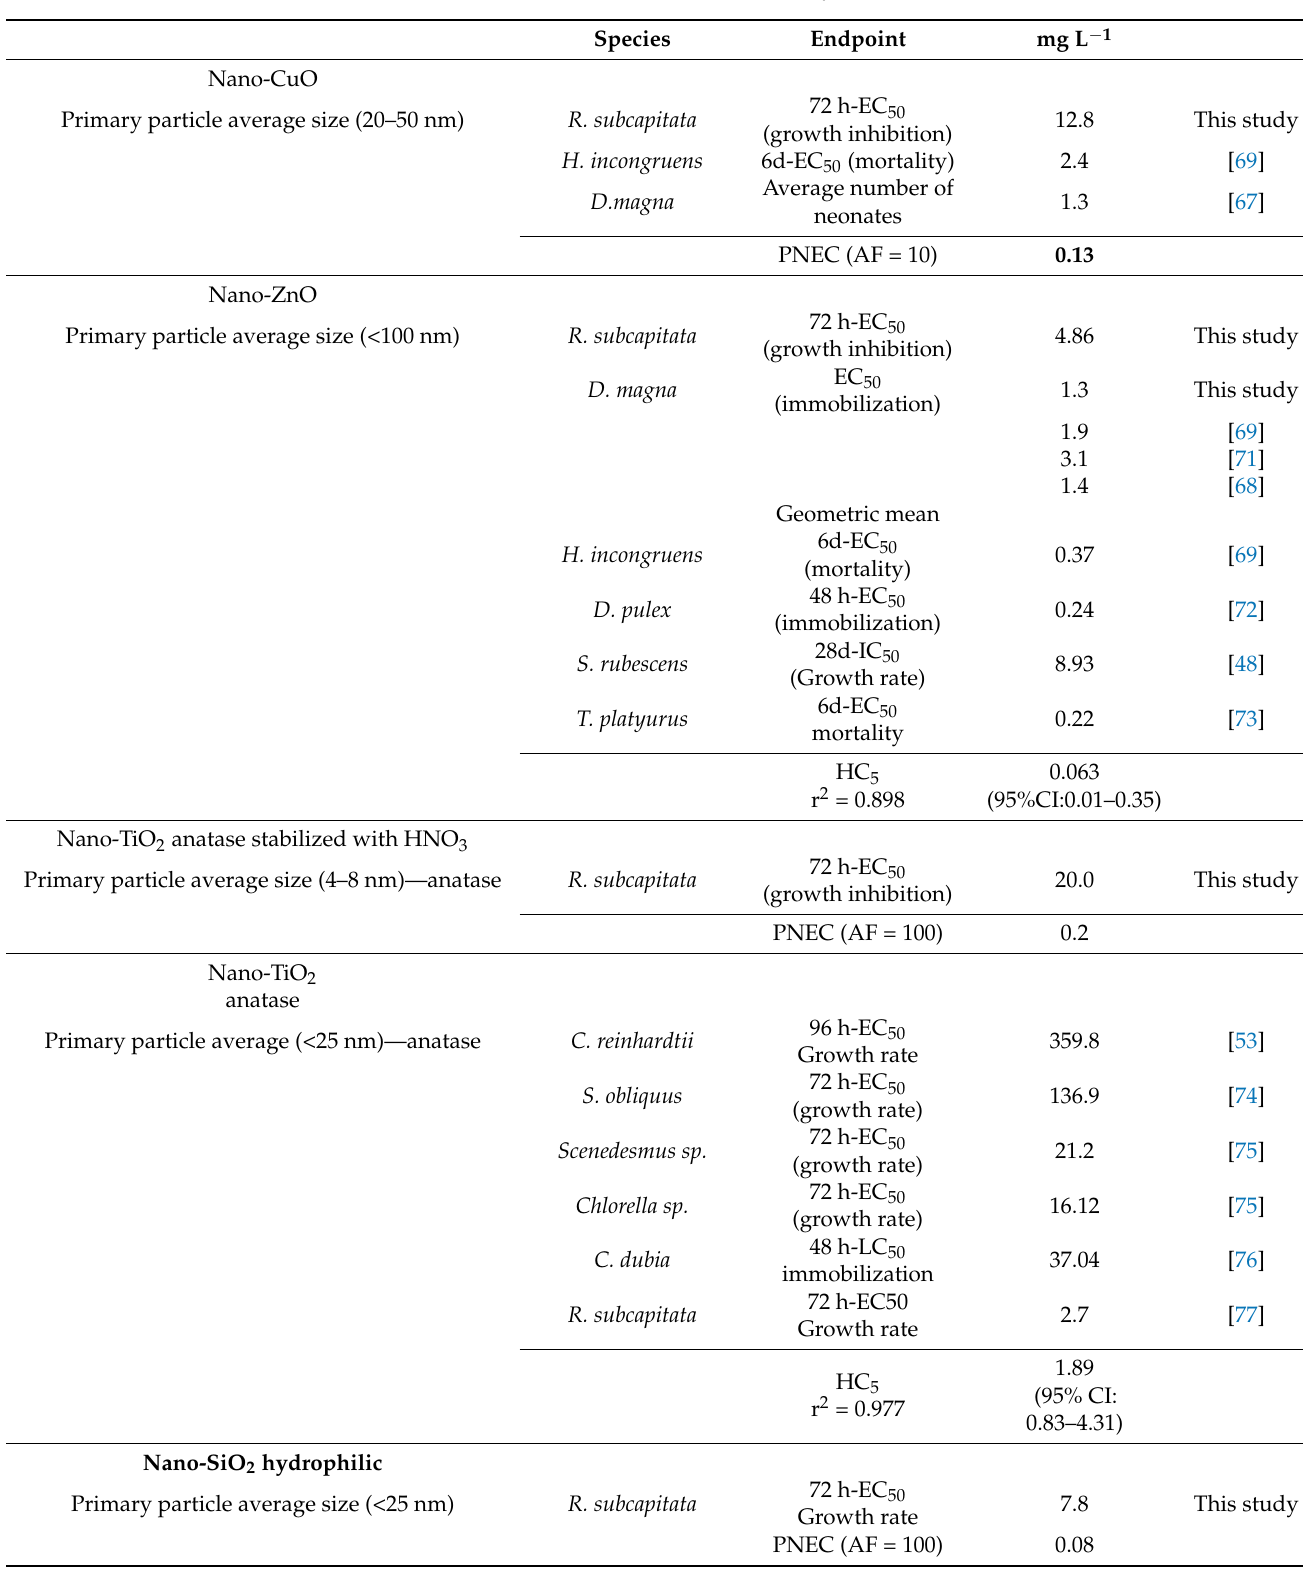
Table 3. Predicted no-effect concentrations (PNEC) or hazard concentrations for 5% of the species (HC 5 ) and corresponding 95% confidence intervals, estimated for the NM under evaluation in this